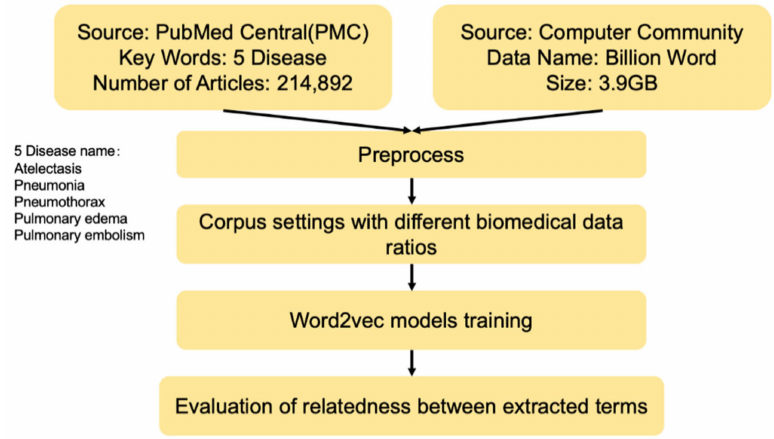
Figure 1. Flow of method of this study.